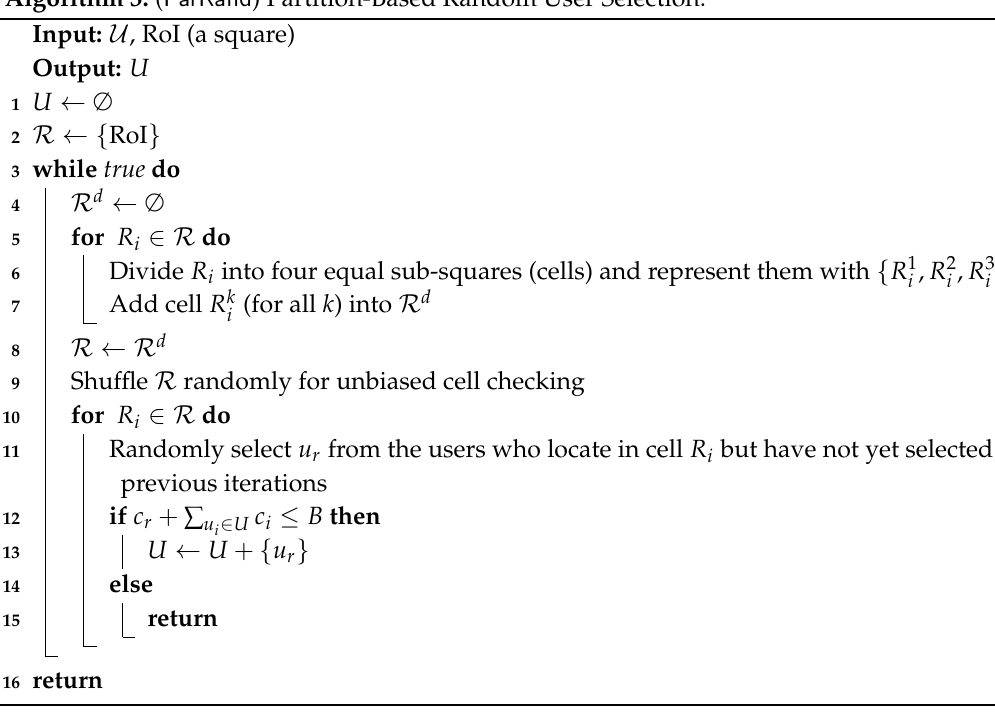
Algorithm 3: ( ParRand ) Partition-Based Random User